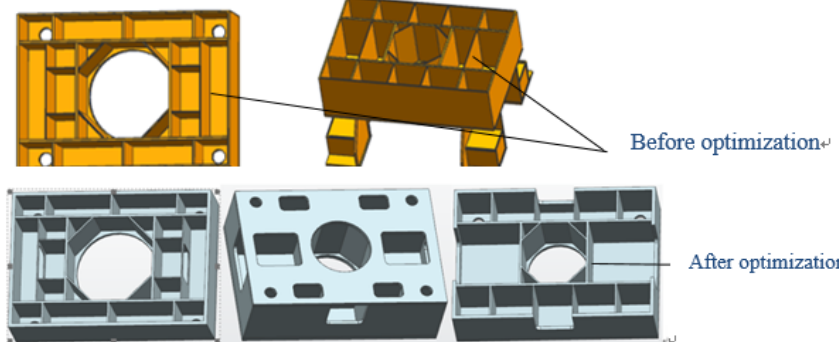
Figure 16. Optimized structure after optimization.